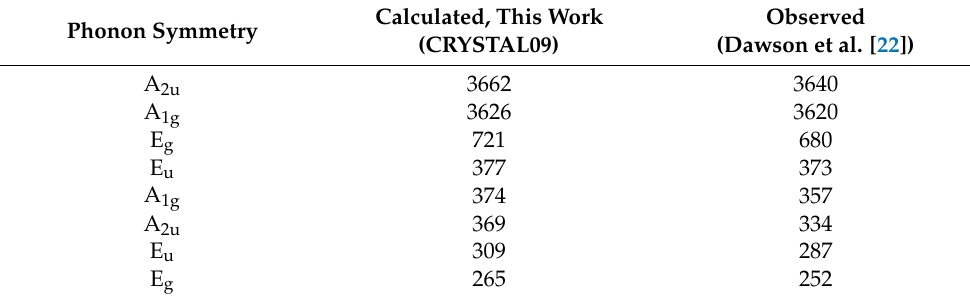
Table 2. Comparison of calculated with observed phonons in Ca(OH) 2 (cm − 1